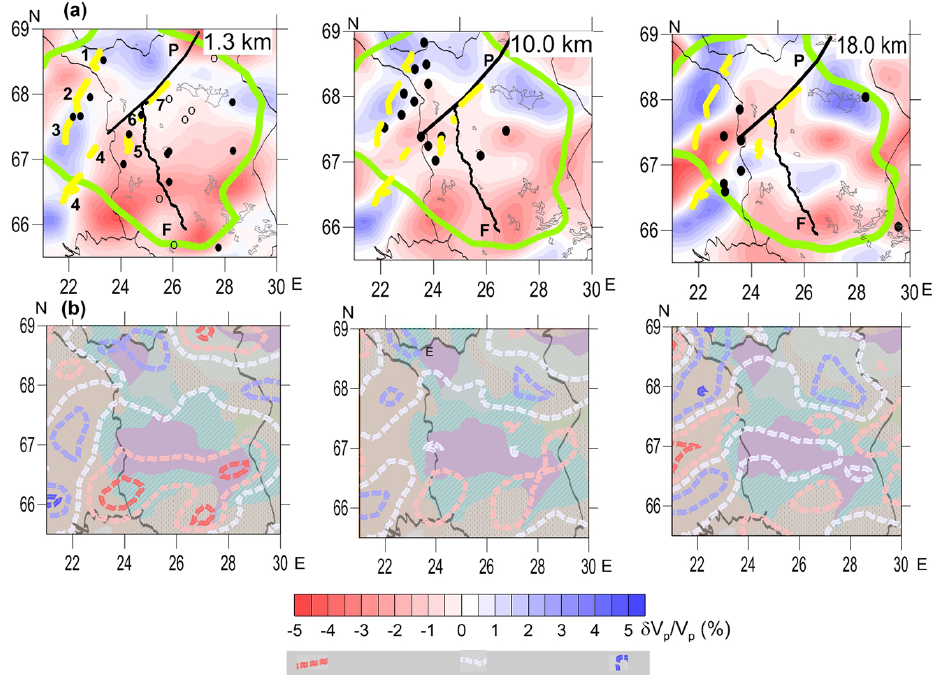
Figure 10. Upper crustal 3-D velocity structure of Region 1 reconstructed with SIMULPS14 and appropriate isolines of velocity anomalies on the background of the geological map. Horizontal cross sections are shown for depths of 1.3, 10.0, and 18.0km after averaging two results derived from two different grids: one with normal orientation and one rotated to an angle of 30 ◦ anticlockwise from the north. Green contours restrict the area with average resolution more than 0.5. Yellow lines denote postglacial faults (detailed description is presented in Fig. 1). Black lines denote position of the profiles: FIRE with the letter F, POLAR with the letter P. Black points show hypocentres of the earthquakes relocated in the 3-D model. In the section corresponding to 1.8km, we show earthquakes with depths<6km; in the section corresponding to 10km we show earthquakes for which 6 ≤ depths<14km; in the section for 18km, we show the earthquakes with depths ≥ 14km. Black blank circles are the explosions shown in the section of